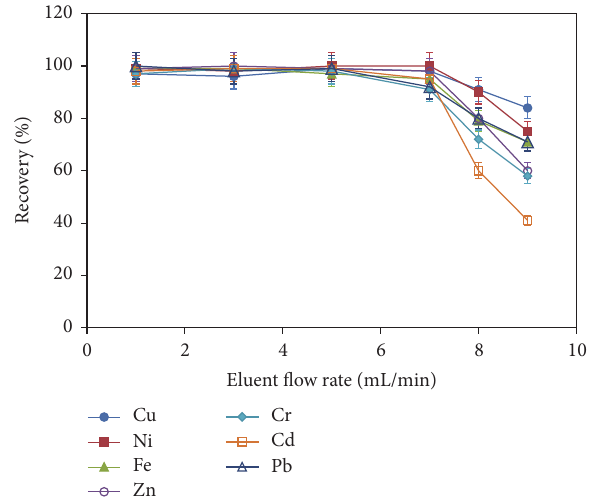
Figure 3: The influence of flow rates of eluent solution on the recoveries of the analyte ions with CR on Amberlite XAD-7 (pH = 7.5; amount of metal ions: 30 𝜇 g Pb(II) and Cr(III), 20 𝜇 g Fe(III), 15 𝜇 g Cu(II) and Ni(II), and 10 𝜇 g Cd(II) and Zn(II); CR amount: 1.0mmol/L; amount of resin: 0.5 g; final volume: 5 mL and 𝑁 = 3 ).